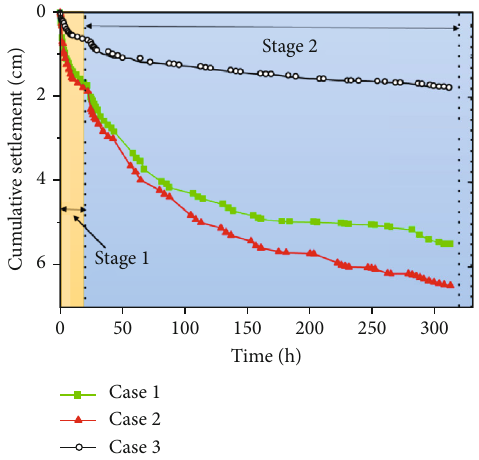
Figure 11: Cumulative settlement curve with time.